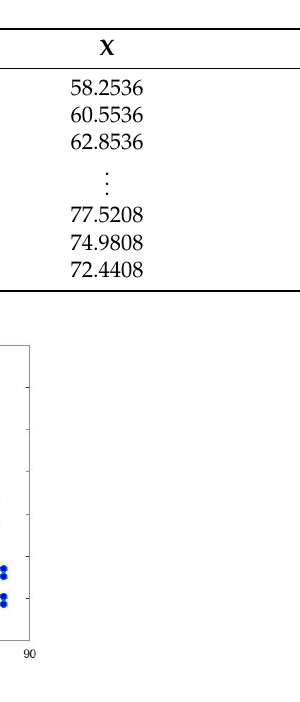
Figure 19. Solder joint position data display.